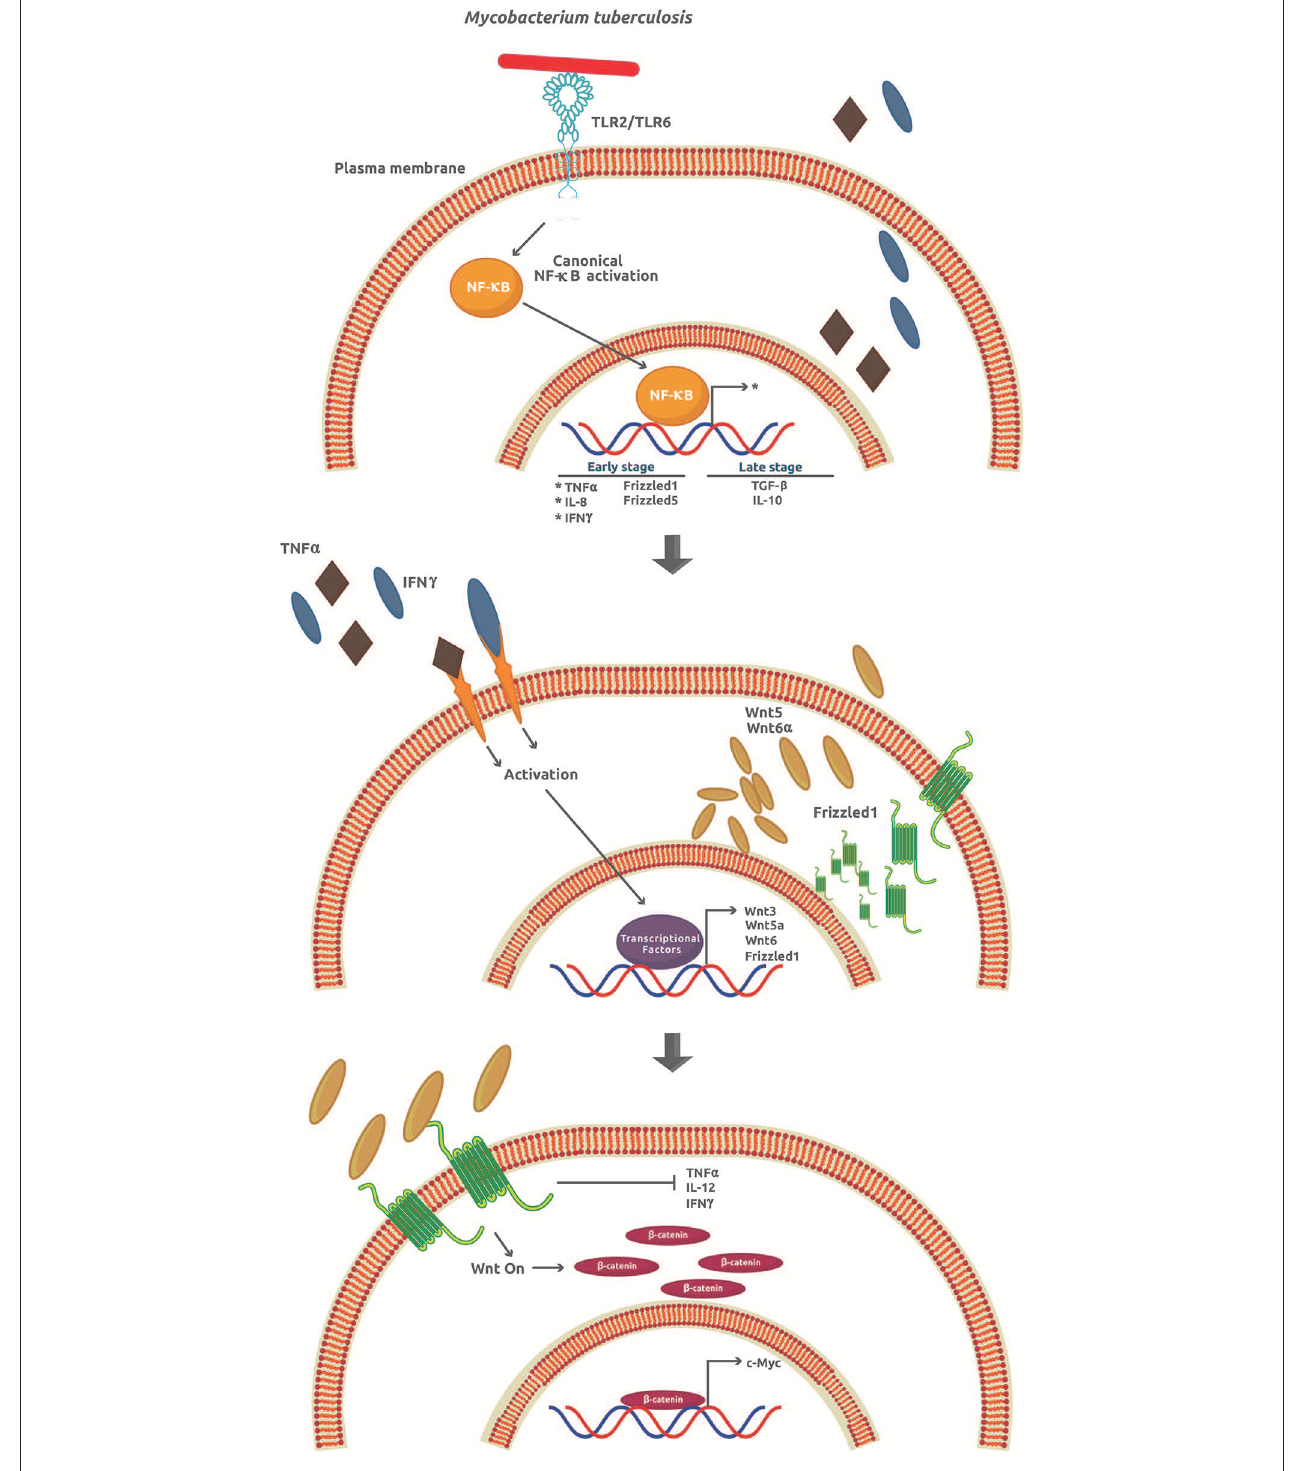
FIGURE 4 | Mycobacterium tuberculosis activates several signaling pathways that lead to an inflammatory response inhibition. During the early phase of infection, M. tuberculosis induces the expression of TNF α , IL-6, IFN γ , Frizzled1, and Frizzled5. However, at later stages of infection, there is an increase of the anti-inflammatory cytokines TGF β and IL-10. The secreted TNF α and IFN γ promote the paracrine expression of Wnt3, Wnt5a, Wnt6, and Frizzled1 that in turn activates the Wnt/ β -catenin signaling.